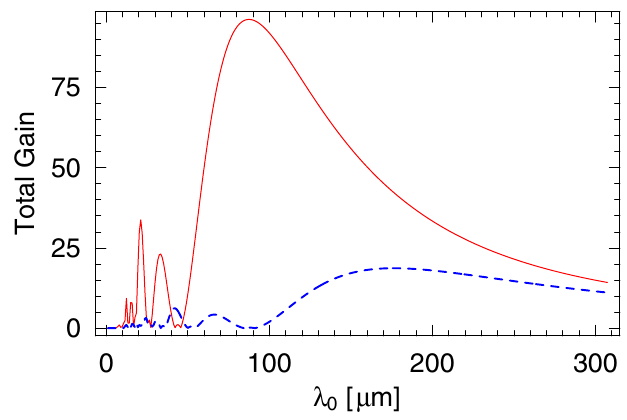
FIG. 2. (Color) Total LCLS microbunching gain after two bunch compressors as a function of the initial modulation wavelength (cid:3) for the laser-heater-induced rms energy spread of 20 keV 0 (solid red curve) and rms energy spread of 40 keV (blue dashed line). The bunch charge is 1